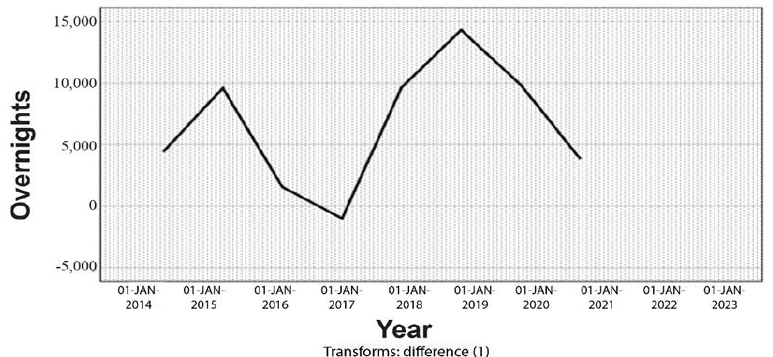
Figure 9. First difference model.